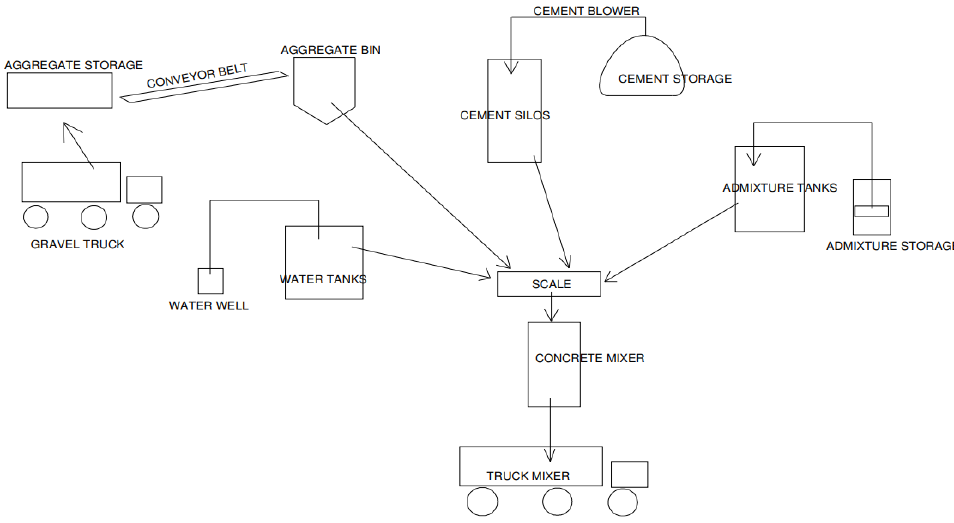
Figure 1. Ready-mix Concrete Production Layout